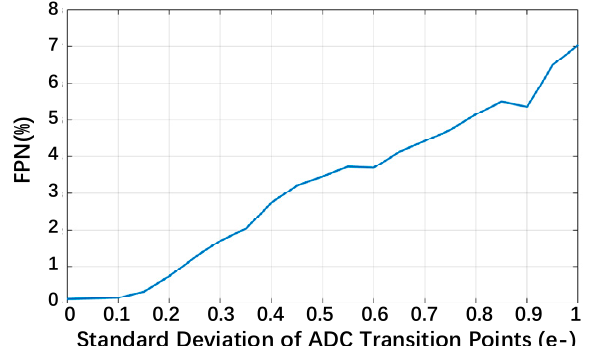
Figure 12. The FPN of reconstructed images with m = 4, z = 16, and n = 4.